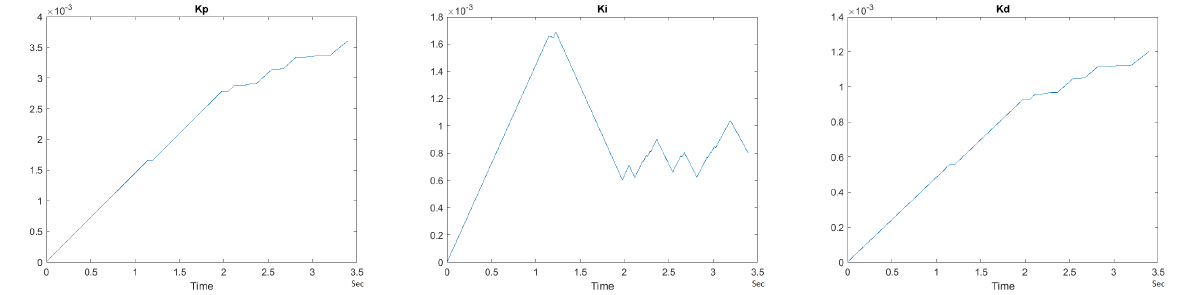
Figure 34. Kp , Ki and Kd parameters for PID++ UP– Vmax 120 cnts/ms, Adesired 0.055 cnts/ms 2 —1